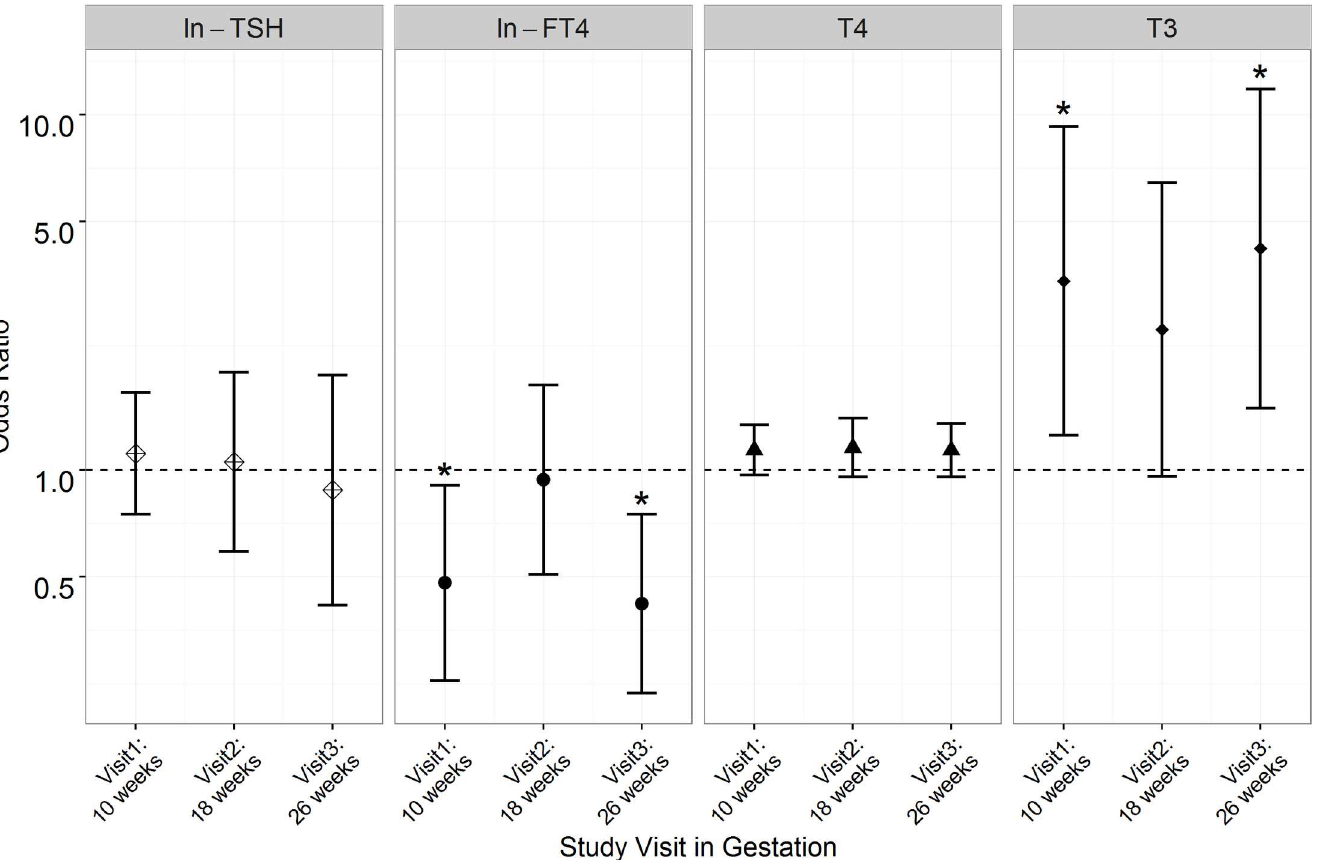
Fig 2. Adjusted odds ratios of spontaneous preterm birth (N = 49 cases)associated with a unit increasein thyroid hormone concentrations ( * p <